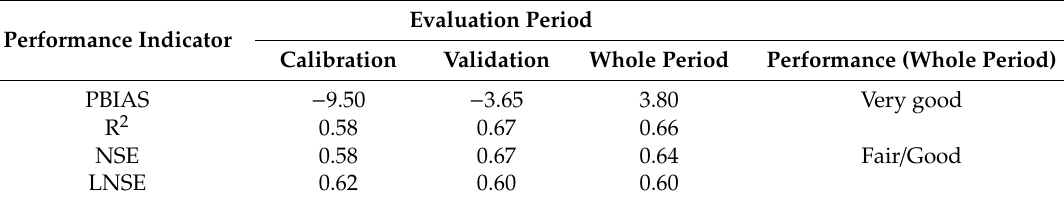
Figure 4. Seasonal distribution of total flow and of stream flow components estimated by the hydrological model. Symbols: ED—surface flow (overland flow due to sealing or saturation excess),